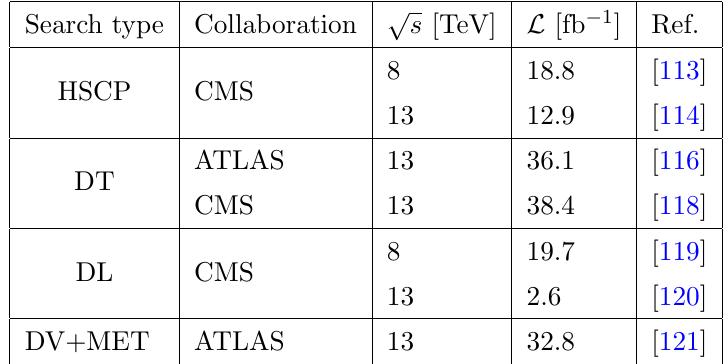
Table 1 . Summary of all LHC searches recasted in this work: Heavy Stable Charged Particles (HSCP), Disappearing Tracks (DT), Displaced Leptons (DL) and Displaced vertices plus MET (DV+MET). We indicate the center-of-mass energy of the run and the integrated luminosity of each dataset. See main text for